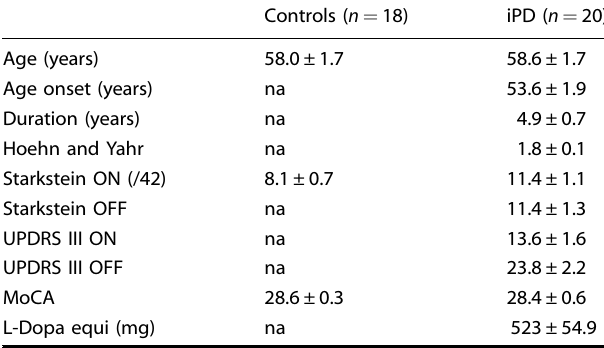
Table 1. Demographics and clinical measures.